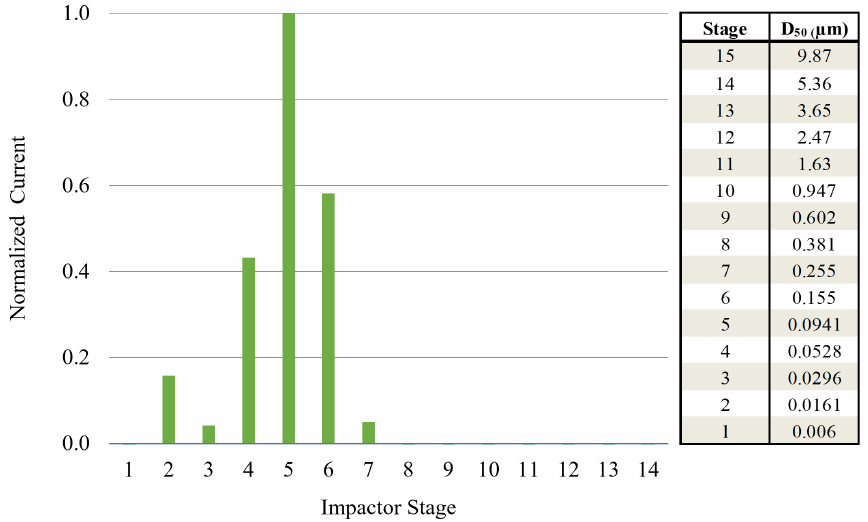
Figure 3. Normalized ELPI current values observed for each impactor stage for 70nm AS particles (initial dry diameter) sampled from 92% chamber RH.